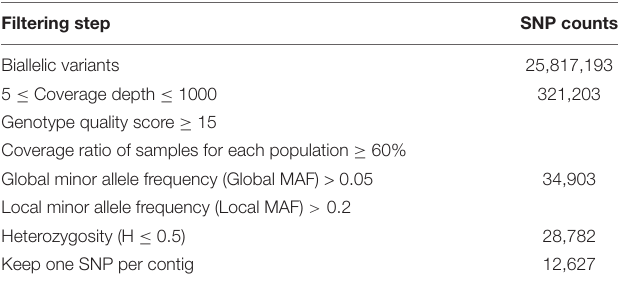
TABLE 2 | Summary statistics for counts of putative SNP loci and final counts of candidate SNPs after different filtering steps.